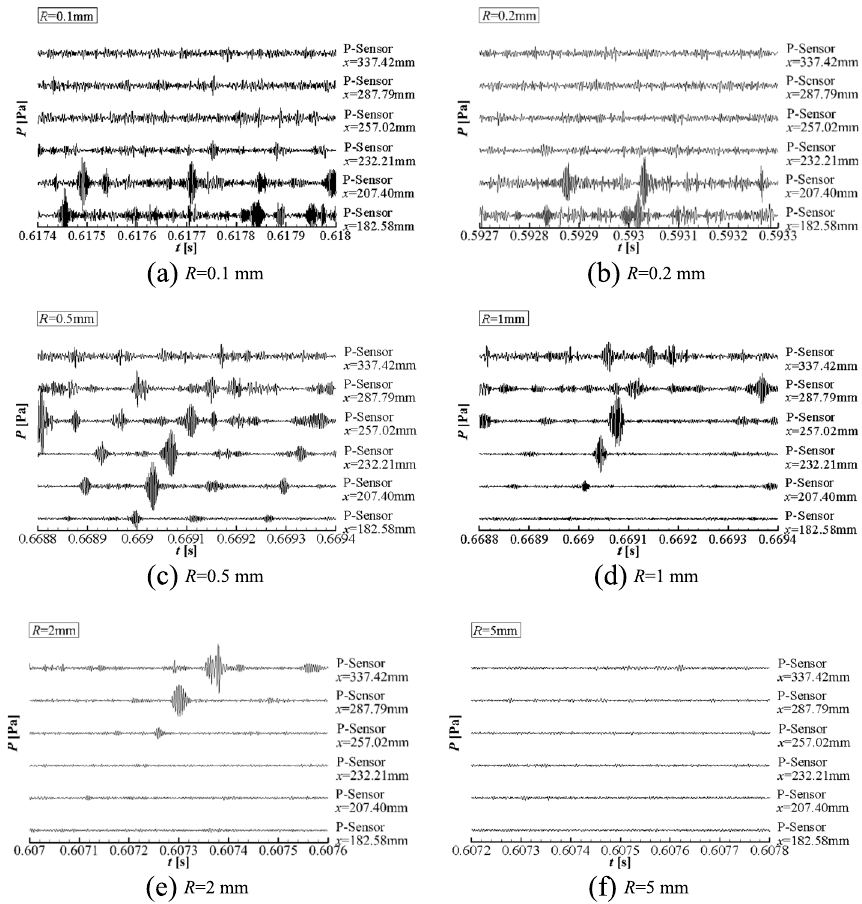
Fig. 12 Time transient of PCB sensors with Re unit